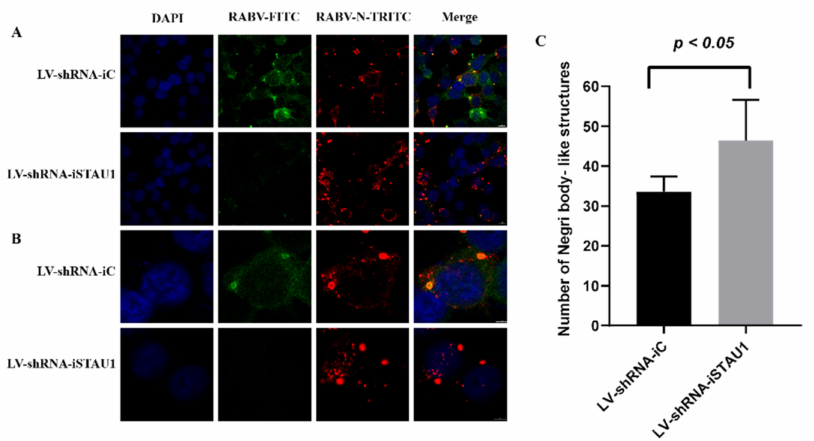
Figure 4. STAU1 affects the formation of Negri body-like structures. ( A ) Subcellular distribu- tion of STAU1 in RABV-infected LV-shRNA-iSTAU1/LV-shRNA-iC cell line, at 48 h post-infection, Bar = 10 µ m. ( B ) Enlarged area of A panels (white box), Bar = 5 µ m. ( C ) Number of Negri body-like structures. Five sets of fluorescence images were randomly selected (Figure 4A, red), and image J counted the number of Negri body-like structures (range size > 50 pixels).